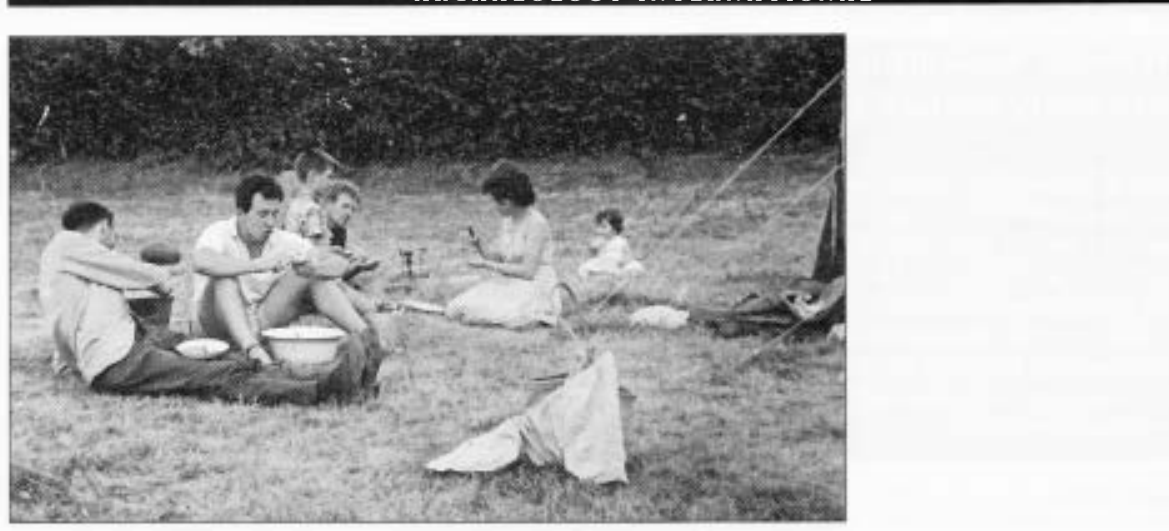
Figure 5 The camping ground at Camp du Charlat. John Ellison and Charles Higham peel potatoes, while Richard Higham wrestles with the prim us while talking to the three children of the local farmer. Note the dormant rugby